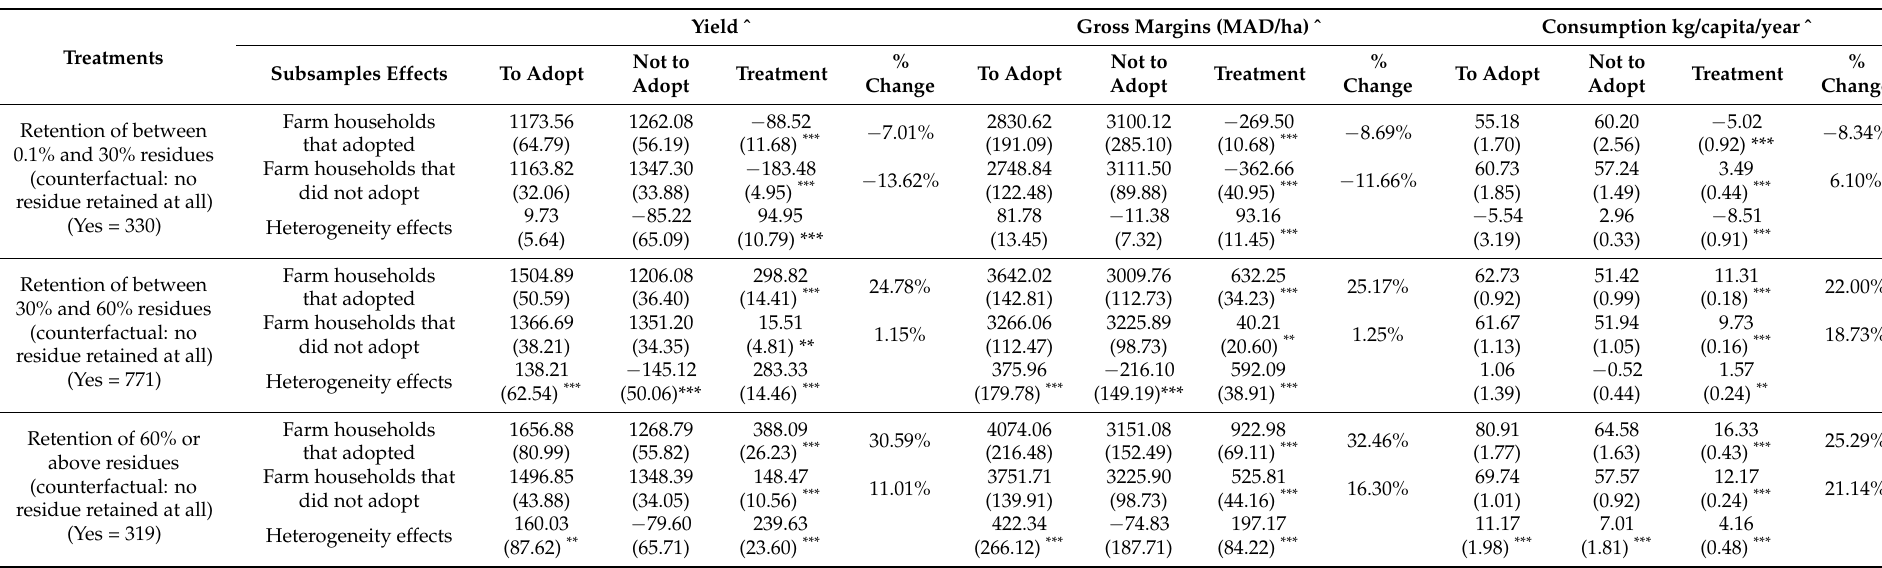
Table 4. Average Expected Treatment and Heterogeneity Effects on Yield, Gross Margin, and Consumption from Endogenous Switching